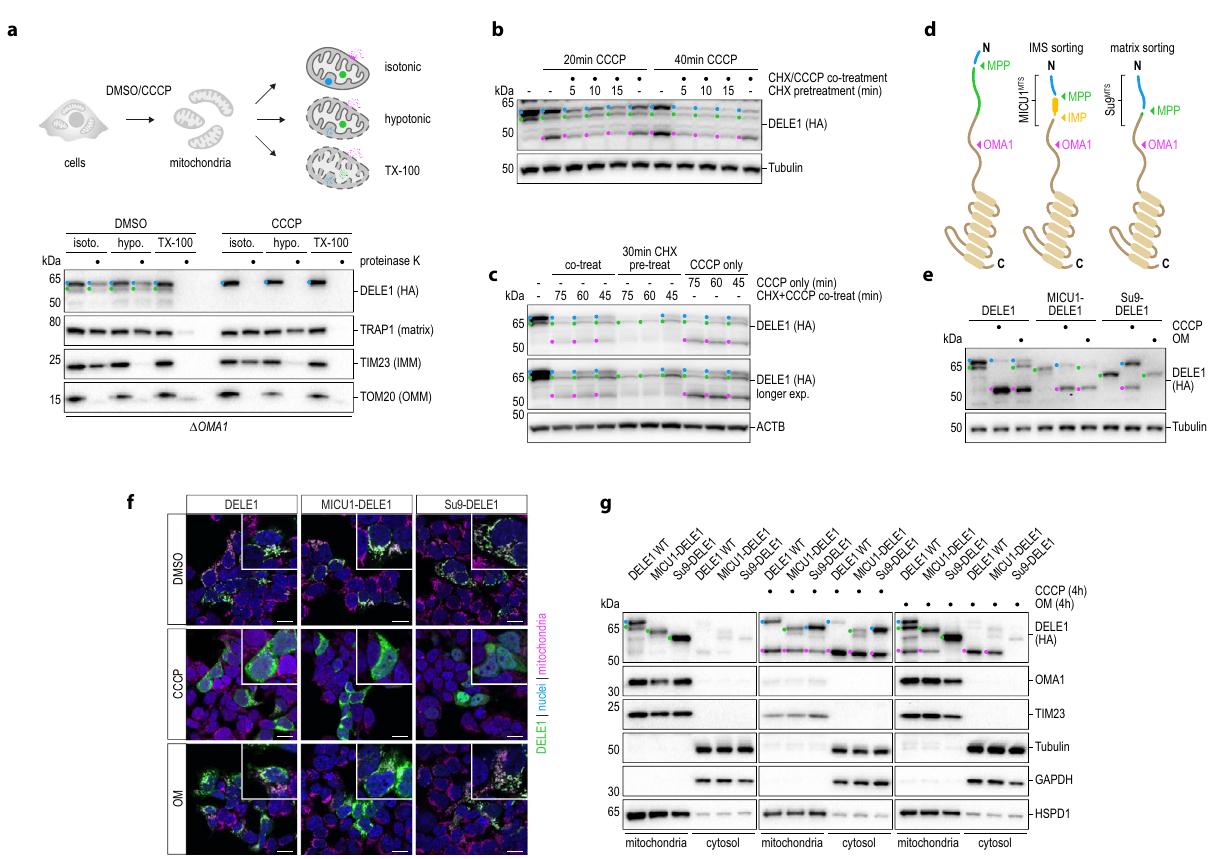
Fig. 3 Release of DELE1 into the cytosol is coupled to sorting and maturation. a Mitochondria isolated from 293T DELE1 HA OMA1 knockout ( Δ OMA1 ) cells treated with DMSO or CCCP for 4 h were processed as in Fig. 2l. b , c HeLa DELE1 HA cells ( b ) and HeLa cells stably expressing DELE1-HA (c) were pretreated with CHX to deplete newly synthesized DELE1 protein, followed by co-treatment of CHX with CCCP for the indicated times and analysis of DELE1 protein by immunoblotting. CCCP only and simultaneous CHX + CCCP treatment without CHX pretreatment serve as controls. d Schematic comparing wild-type DELE1 and chimeric DELE1 proteins carrying a heterologous MTS and their associated protease cleavage sites, used in the subsequent panels. e 293T DELE1 knockout cells stably expressing the indicated DELE1 variants were treated with CCCP or OM for 6 h. Processing of the DELE1 proteins was analyzed by immunoblotting. f 293T DELE1 knockout cells were transiently transfected with the speci fi ed DELE1 chimeras, treated for 4 h as indicated and analyzed by confocal microscopy. Scale bars, 20 μ m. Nuclei (DAPI, blue), mitochondria (MitoTrackerRed, pink), DELE1 (HA, green). g Subcellular fractionation reveals the localization of different DELE1 species to mitochondria or cytosol upon CCCP or OM treatment in 293T DELE1 knockout cells transiently transfected with the indicated